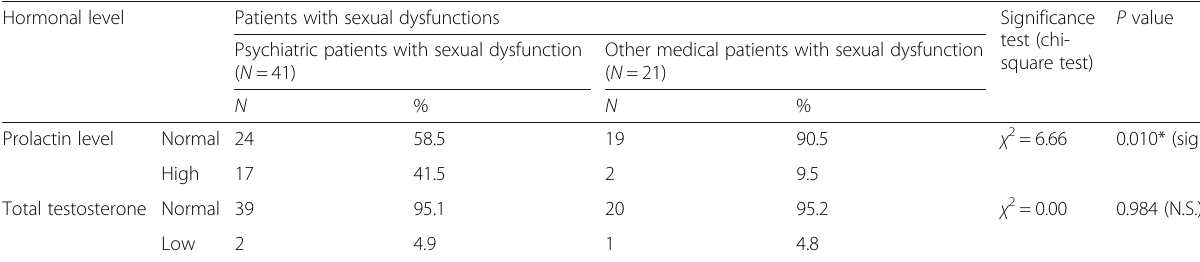
Table 13 Comparison of hormonal levels among psychiatric patients with sexual dysfunctions and other medical patients with sexual dysfunctions Patients with sexual dysfunctions